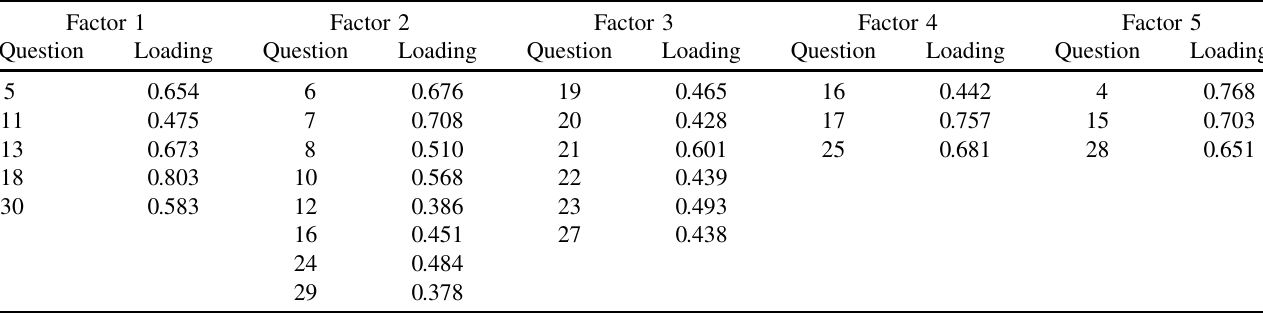
TABLE III. The assignment of FCI questions to nonorthogonal factors is shown.